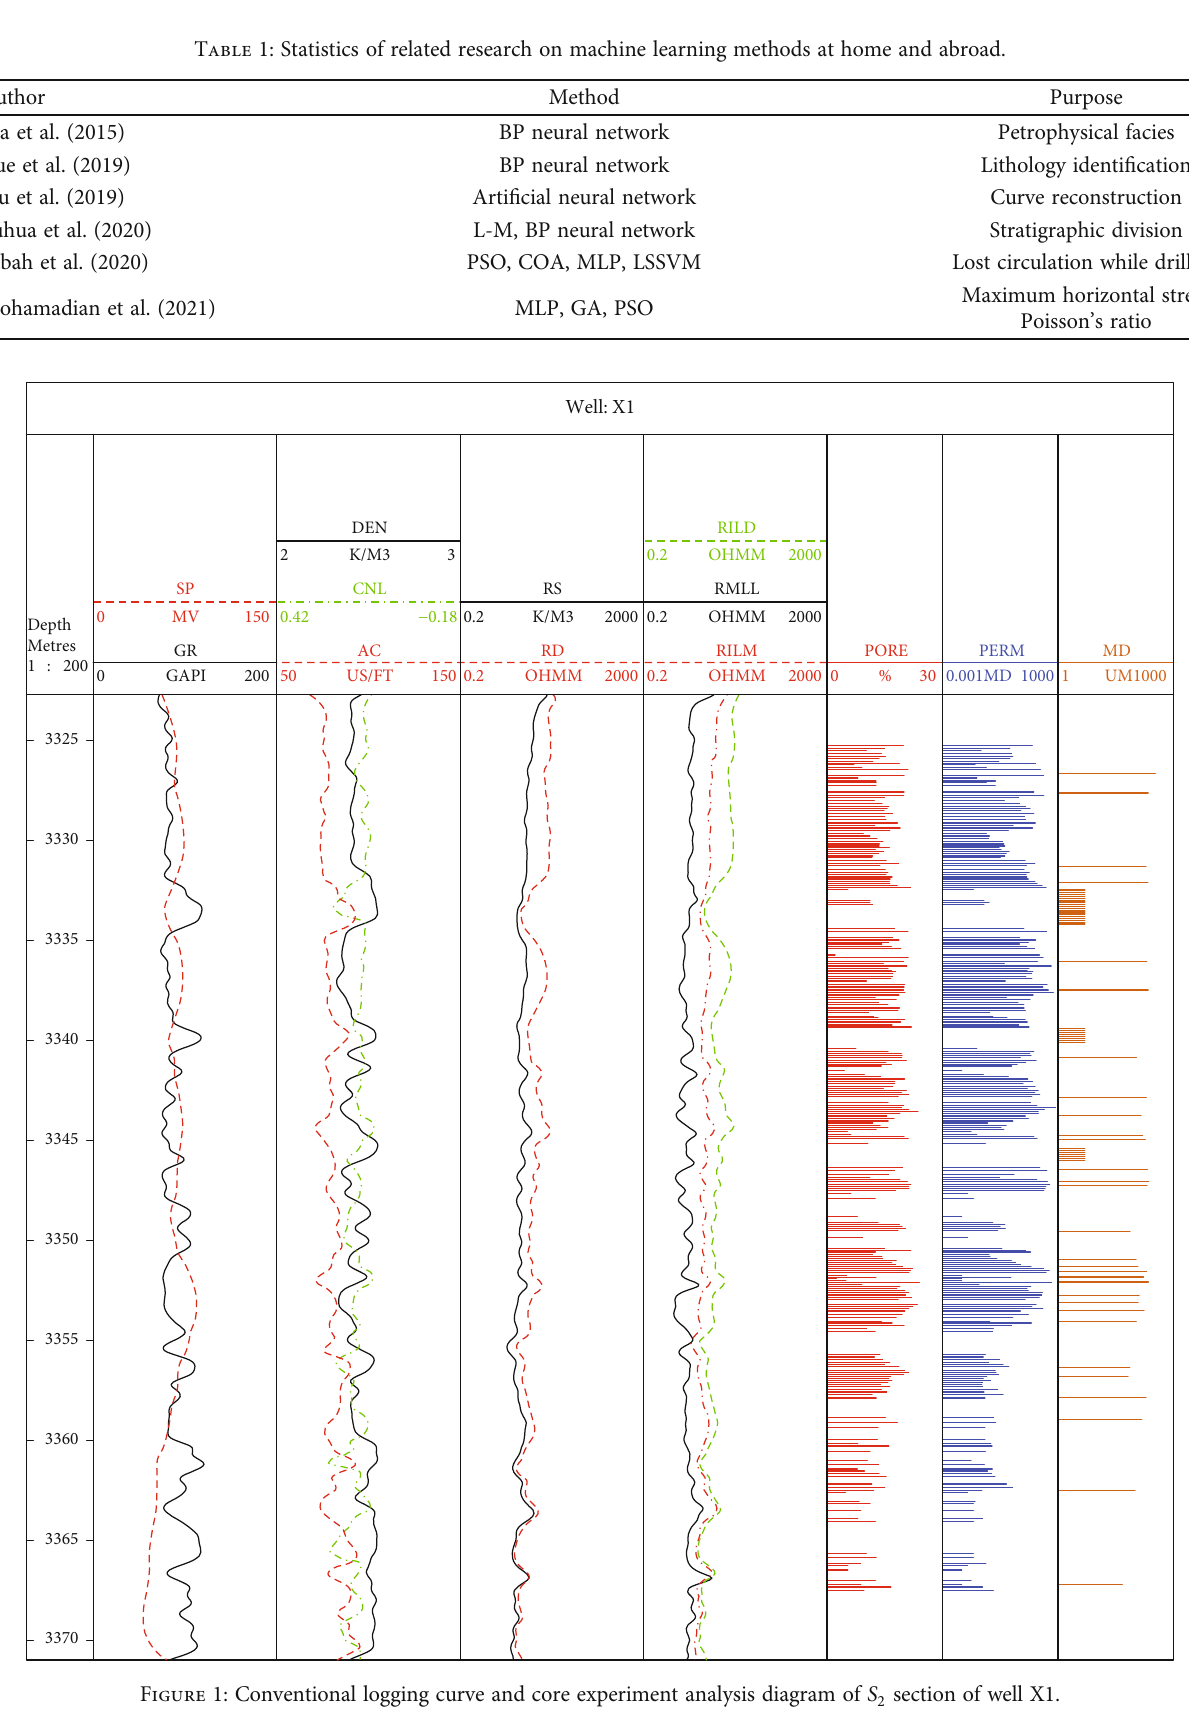
section of well X1. 2